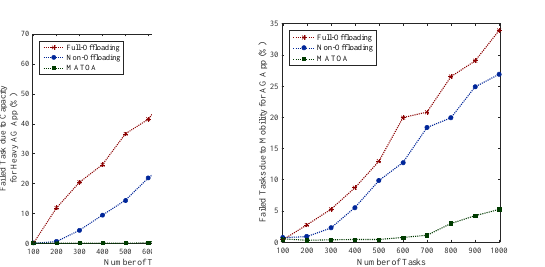
Figure 7. The mean plot of ęÓ with 95.0% Tukey HSD intervals and The mean plot of workflow Application rules with 95.0% Tukey HSD intervals